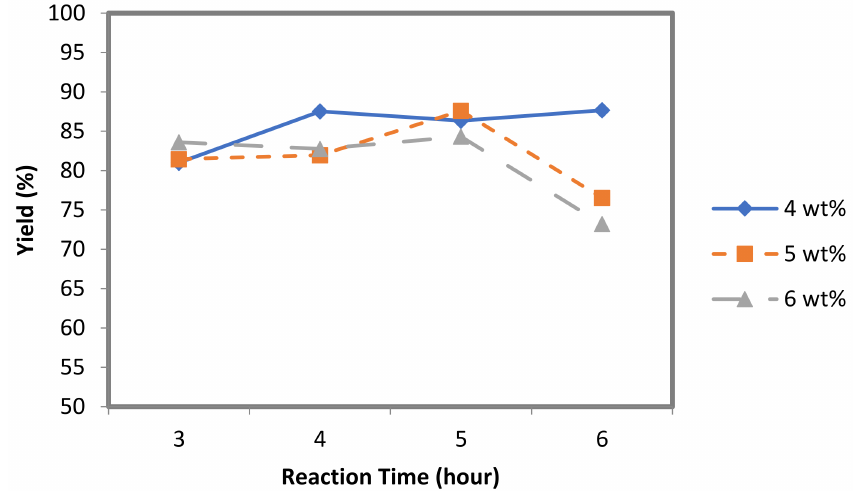
Figure 3. Influence of catalyst loading on the yield (methanol to oil molar ratio 12:1, temperature 55 ◦ C, stirring rate 700 rpm, reaction time 3–6